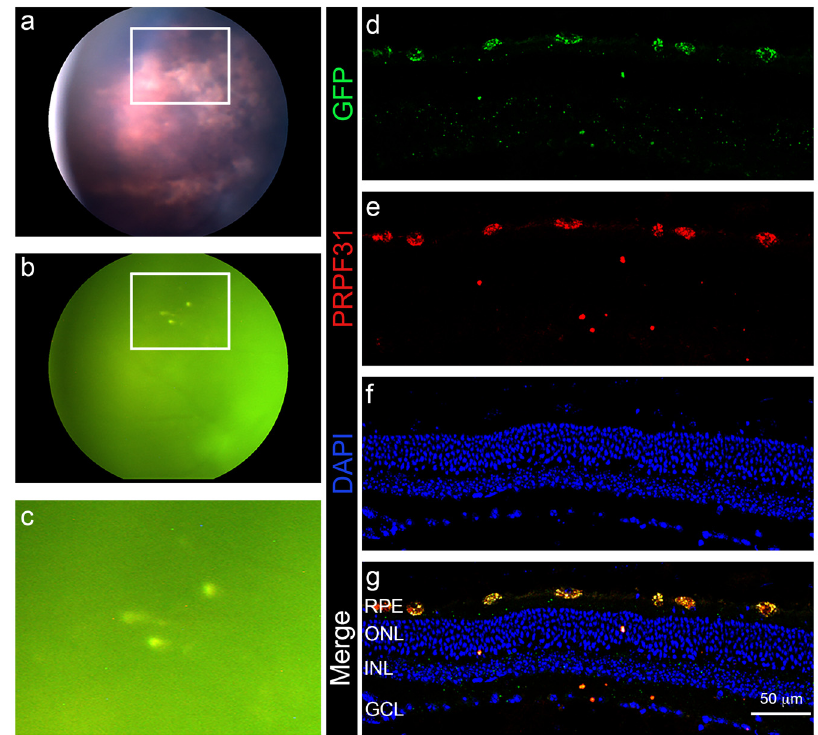
Figure 6. Fundus images and the retinal section of PRPF31 -GFP/N-MSiNP subretinally injected mice. ( a ) Fundus image. ( b ) Fluorescence fundus. ( c ) Detail of the injection site showing GFP fluorescent dots. Immunostaining of retinal sections for GFP ( d ), in green; PRPF31 ( e ), in red. Nuclei stained with DAPI ( f ), in blue. ( g ) Merged images of the different channels. GFP and PRPF31 signal co-localized mainly in RPE cells. RPE = retinal pigment epithelium, ONL = outer nuclear layer, INL = inner nuclear layer, GCL = ganglion cell layer. Scale bar represents 50 µm.